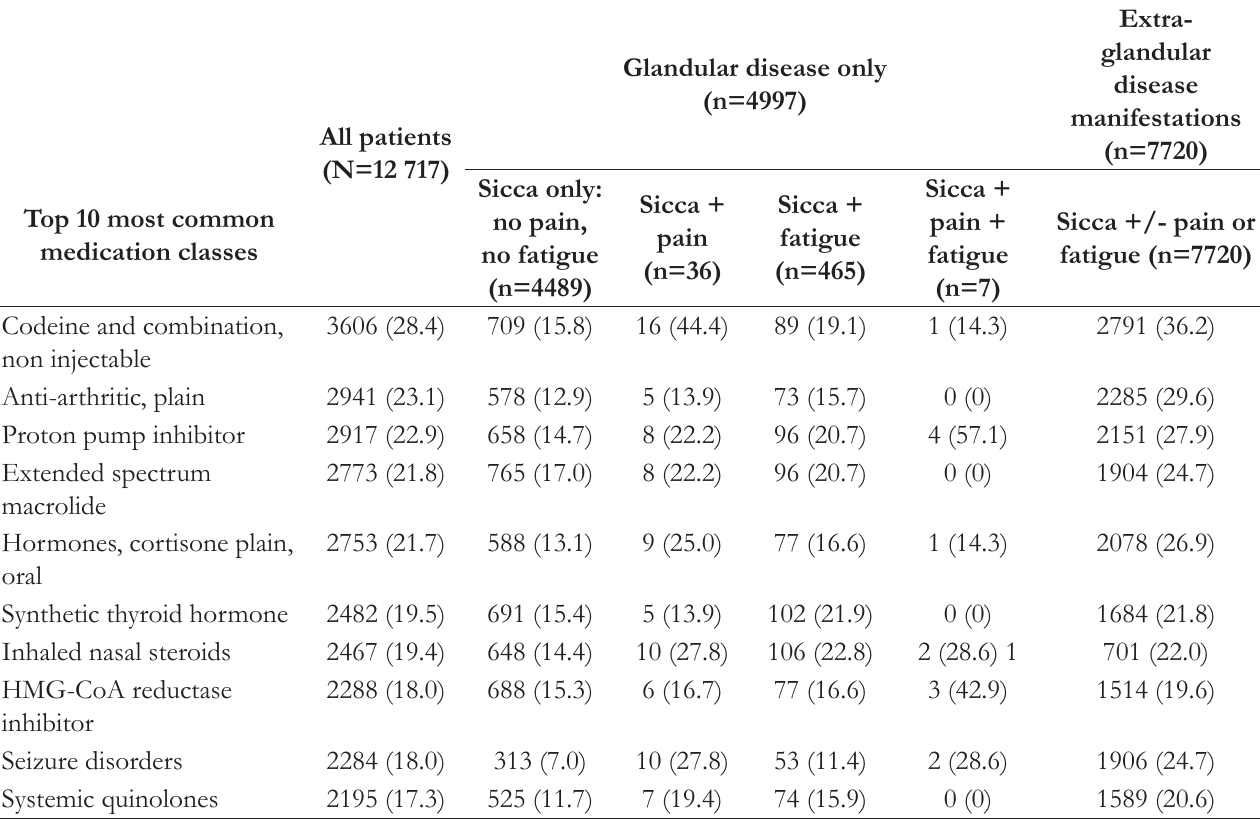
Table 4. Top Ten Most Common Medication Classes in the Primary Cohort and by Disease Characterization